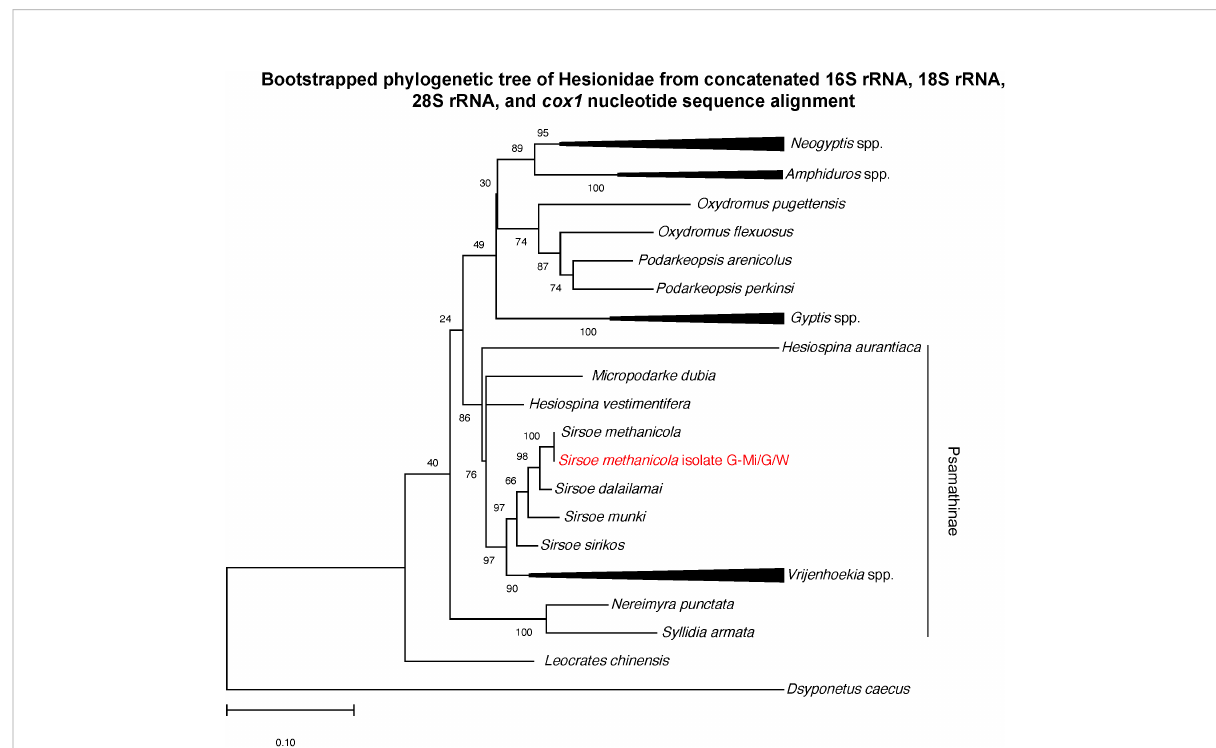
FIGURE 4 Bootstrapped maximum likelihood phylogenetic tree of concatenated 16S rRNA, 18S rRNA, 28S rRNA, and cox1 nucleotide sequences from S . methanicola metagenomic libraries G/W/G-Mi (red text) in relation to sequences from other species in the family Hesionidae . The tree was constructed by MEGAX from the concatenated 1,446-bp alignment from 33 specimens. The tree with the highest log likelihood ( – 10081.68) is shown, with branch lengths indicating the number of substitutions per site. Bootstrap values on tree nodes indicate the percentage of trees, based on 1,000 replicates, in which taxa from a node are clustered together. The outgroup species used was Dsyponetus caecus from the polychaete family Chrysopetalidae . Accession numbers of these sequences are provided in Table